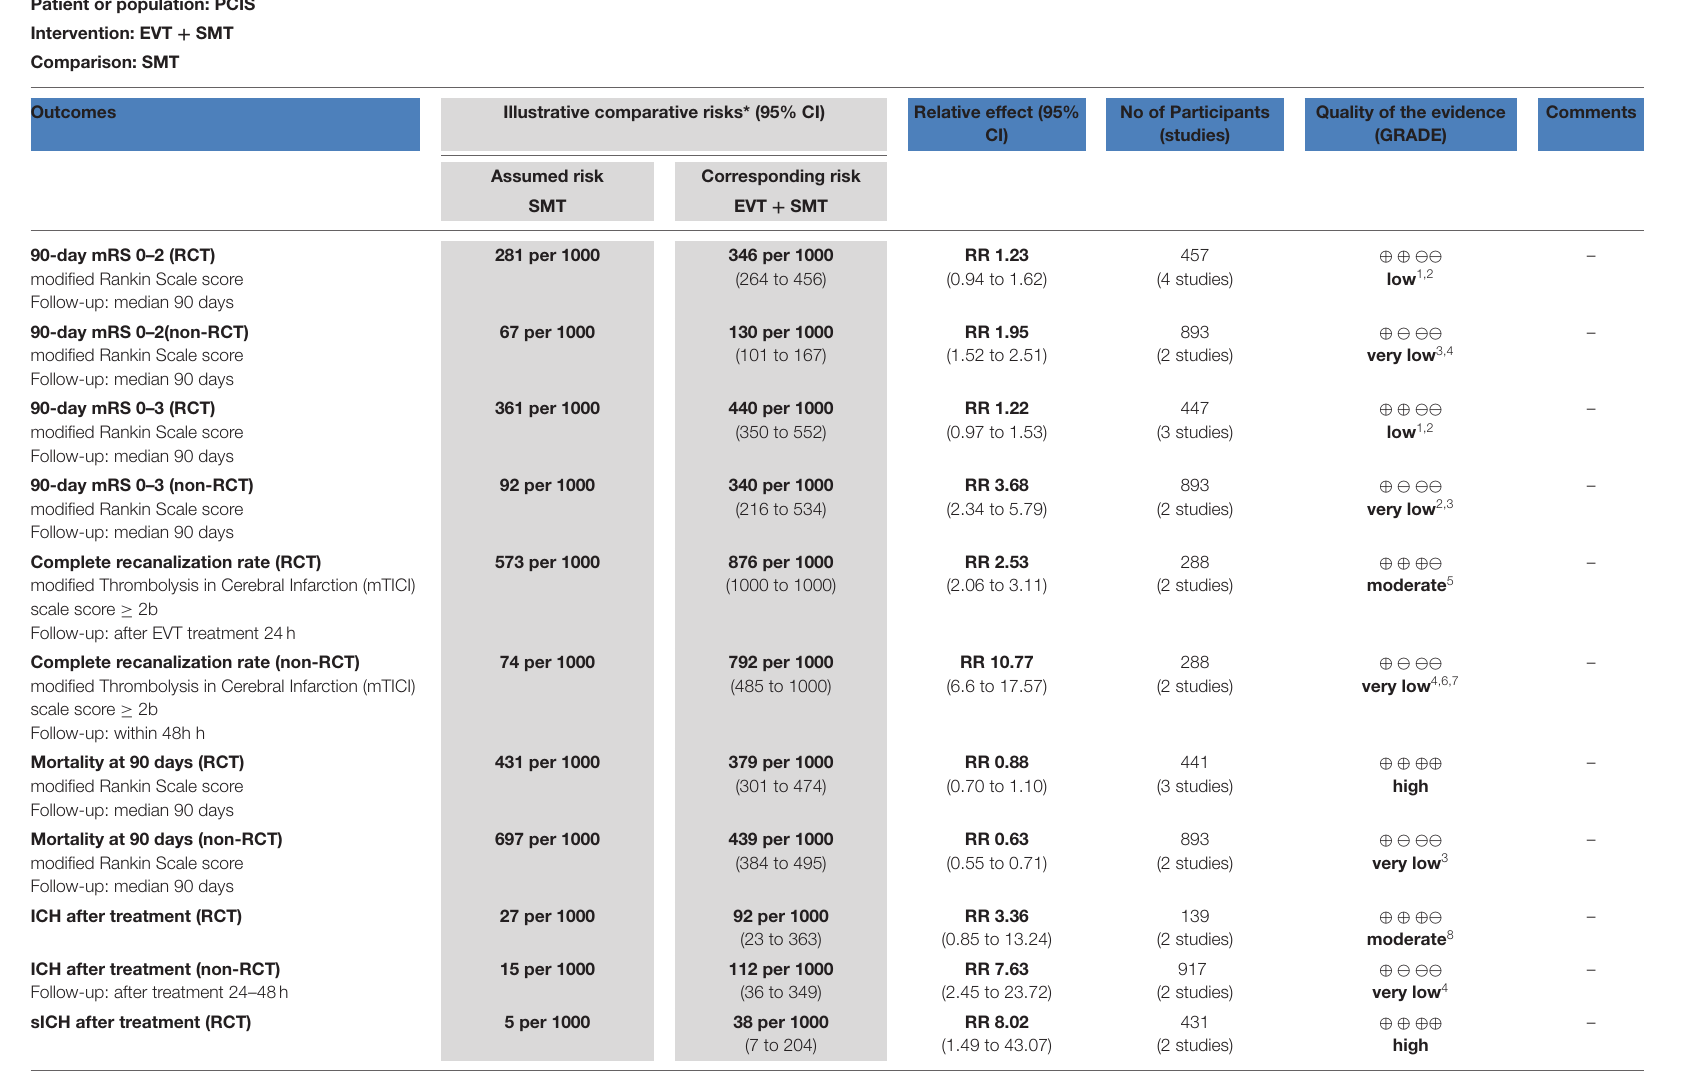
TABLE 4 | The summary of findings table based on GRADE